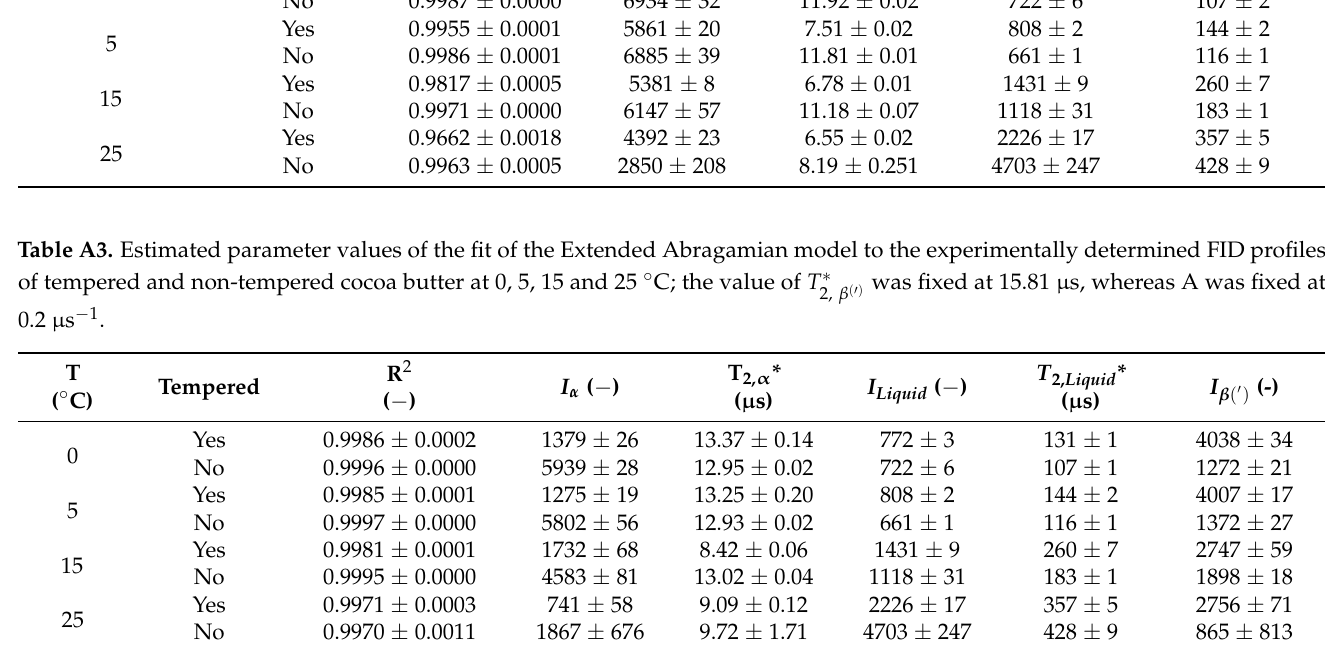
Table A2. Estimated parameter values of the fit of the Bi-Gaussian model to the experimentally determined FID profiles of tempered and non-tempered cocoa butter at 0, 5, 15 and 25 ◦ C.